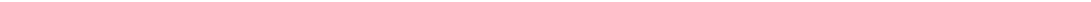
Fig. 3 The metabolism of nuclear WT and mutant Blimp-1 proteins is triggered by PML-mediated Sumo-2/3 modi fi cation. a WT or mutant Blimp-1-expressing plasmids were co-transfected with empty plasmid (pcDNA3.0 ( − ) B) or PIAS1 − , PIAS2 α − , PIAS2 β − , PIAS3 − , PIAS4 − , CBX4 − , or PML-expressing plasmids into 293T cells. Total lysates were analyzed by western blotting. b WT or mutant Blimp-1-expressing plasmids were co-transfected with empty plasmid (pCMV6-AC-DDK) or PML − , CBX4 − , or PIAS1 − expressing plasmid into 293T cells, which were then treated with MG132 or left untreated for 12 h. The lysates were immunoprecipitated with anti- fl ag antibody and then immunoblotted with antibodies against Sumo-1 or Sumo-2/3. c PML − / − HeLa cells supplemented with mCherry-tagged PML were transduced with GFP-tagged WT or mutant Blimp-1-expressing plasmids and then treated with MG132 for 12 h before being inspected under a confocal microscope. Scale bar : 7.5 μ m. d PML − / − HeLa cells with or without PML supplementation were treated with MG132 or left untreated for 24 h before whole-cell lysates were collected for immunoprecipitation and western blotting. e PML − / − HeLa cells with or without PML supplementation were transduced with fl ag-tagged WT or mutant Blimp-1-expressing plasmids for 48 h before being analyzed via western blotting. f WT or mutant Blimp-1-expressing plasmids were co-transfected with empty plasmid (pCMV6-AC-DDK) or PML-expressing plasmids into 293T cells and treated with MG132 or left untreated for 24 h. The nuclear lysates were immunoprecipitated with an anti- fl ag antibody and then immunoblotted with an antibody against Ub. g WT or mutant Blimp-1-expressing plasmids were transfected alone or together with si-SUMO-2/3 into PML-overexpressing 293T cells, which were then treated with MG132 or left untreated for 24 h. The nuclear lysates were immunoprecipitated with an anti- fl ag antibody and then immunoblotted with an antibody against